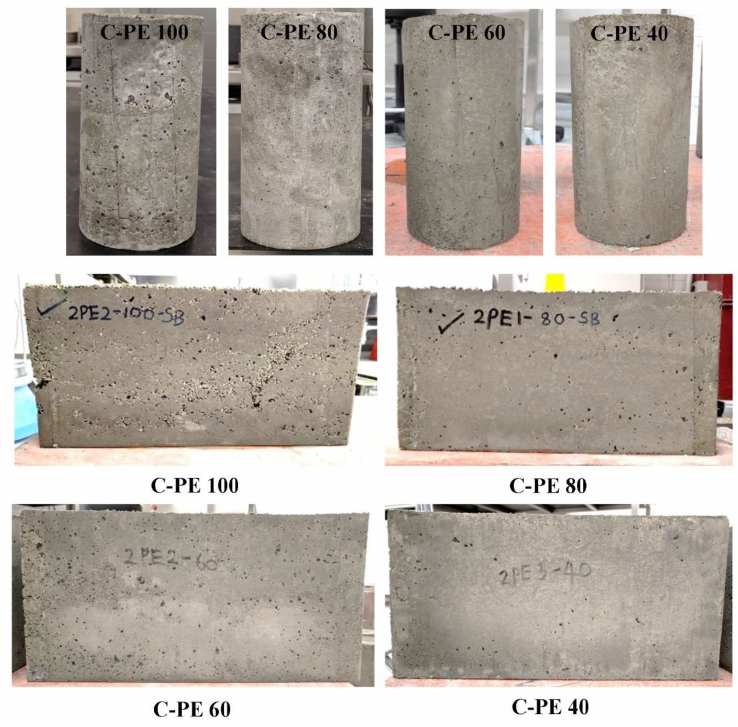
Figure 21. Cylinder and block specimens of C-PE